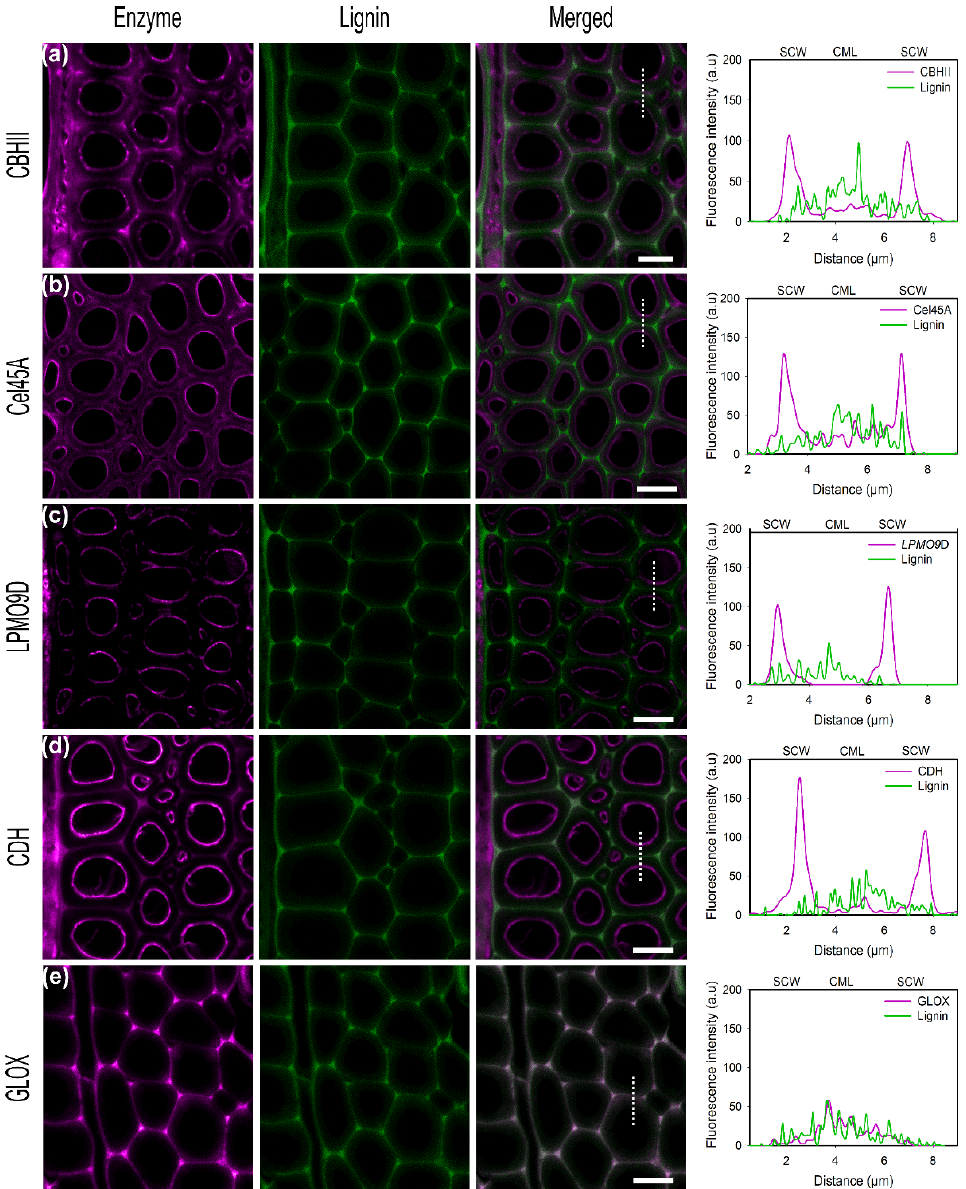
Figure 4. CLSM images of conjugated enzymes ( a ) CBHII, ( b ) Cel45A, ( c ) LPMO9D, ( d ) CDH, ( e ) GLOX on delignified poplar cross-sections showing fiber cells. Enzyme fluorescence is colored in magenta. Lignin autofluorescence is shown in green. The merged column displays the overlay of enzyme and autofluorescence channels. Graphs show the overlay profile (dash line) of line scans over the fiber cell wall, showing secondary cell walls (SCW) and compound middle lamella (CML). Scale bars correspond to 10 µm.